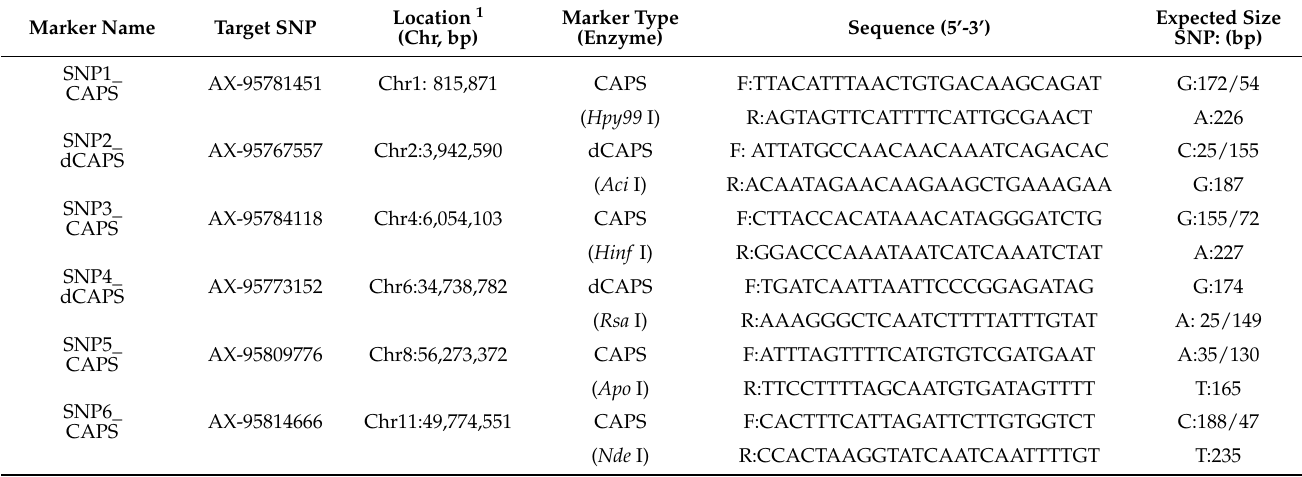
Table 6. The cleaved amplified polymorphic sequence (CAPS) and derived cleaved amplified poly- morphic sequence (dCAPS) marker information designed to validate the single nucleotide polymor- phism (SNP) genotyping results of the Axiom ® Tomato Genotyping